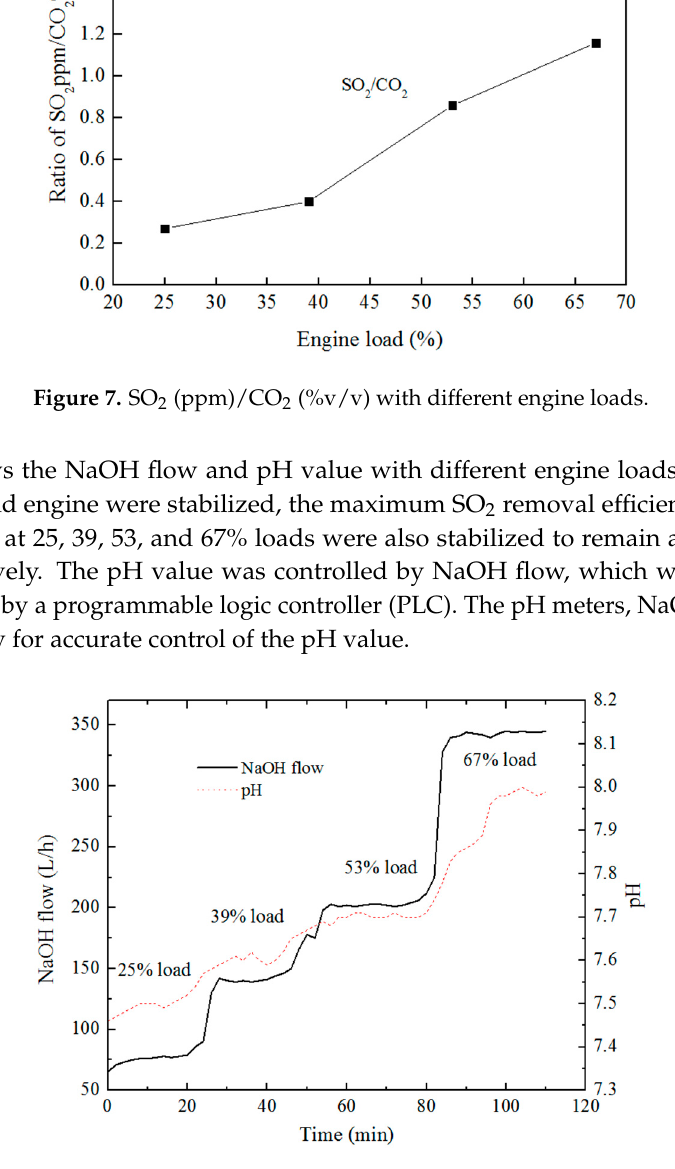
Figure 8. NaOH flow and pH value with different engine loads.